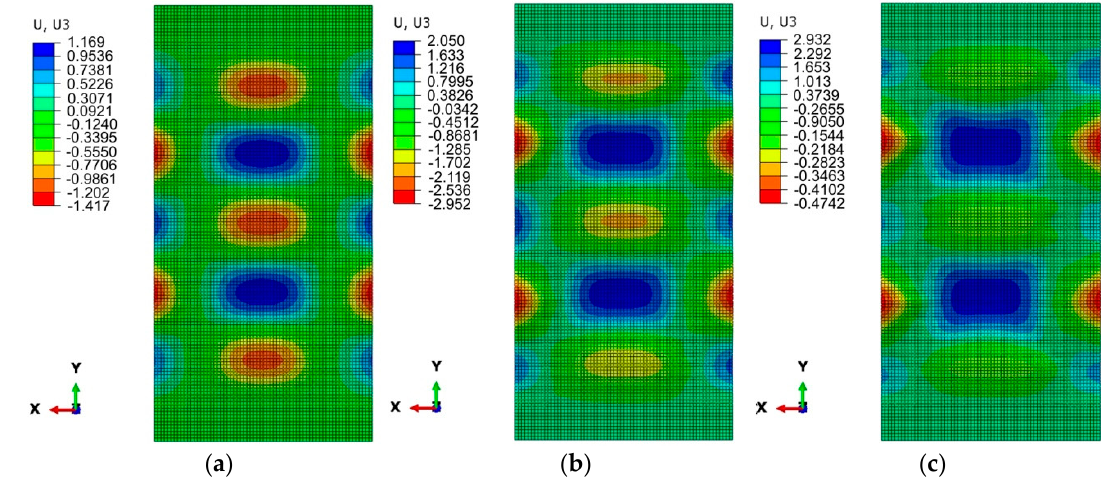
Figure 7. Deformation of a stiffened panel with welded stringers in a postcritical state ( s = 29.5 mm) when subjected to a compressive force of: 0.25 F max ( a ), 0.5 F max ( b ) and 0.75 F max ( c ).